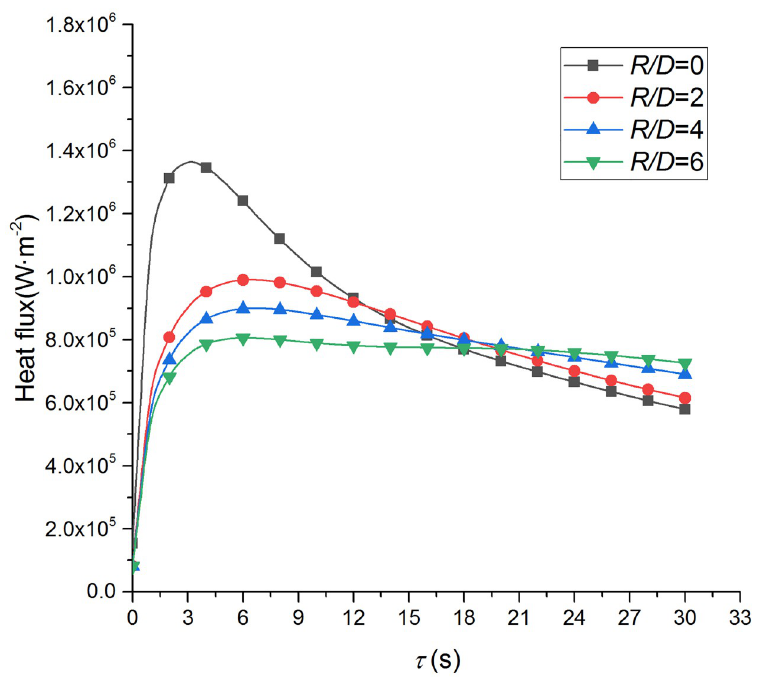
Fig 23. Heat flux of the supersonic air jet impingement.